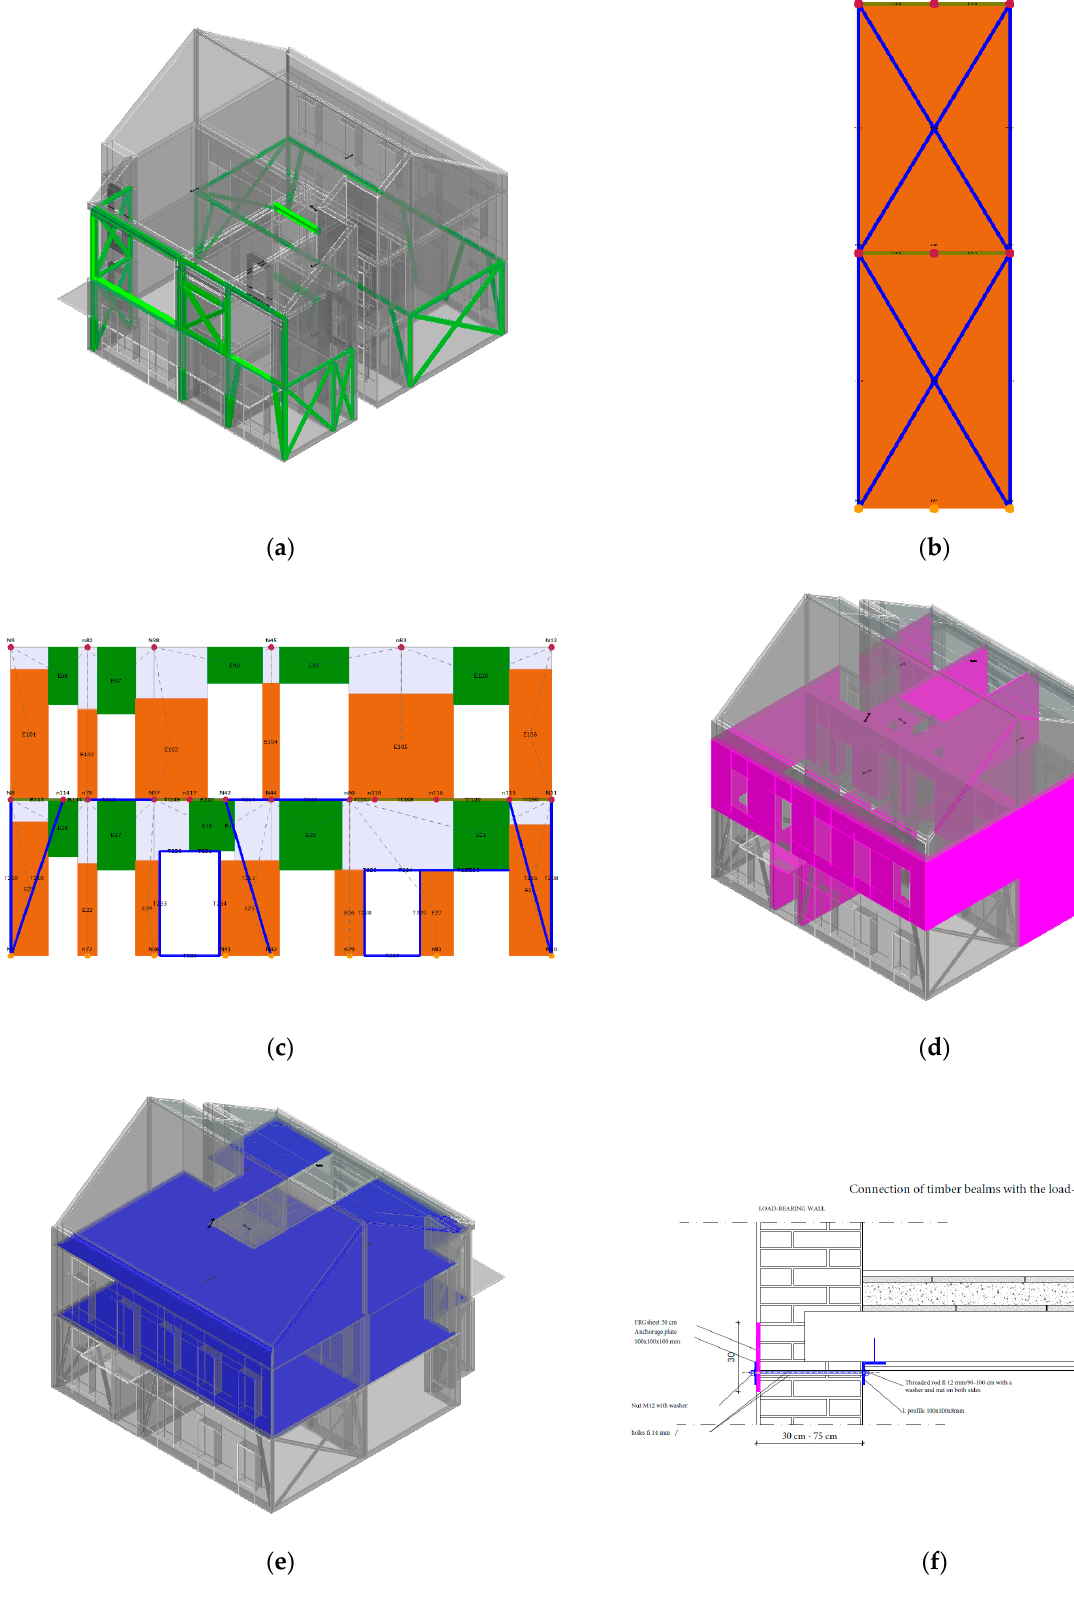
Figure 17. 3Muri 3D strengthened model ( a ) steel structure; ( b) braced frame; ( c ) steel ring-frame around the doors; ( d ) Strengthening of the walls with FRCM; ( e ) Strengthening of the walls with OSB; ( f ) Connection of the timber beams with load-bearing walls.